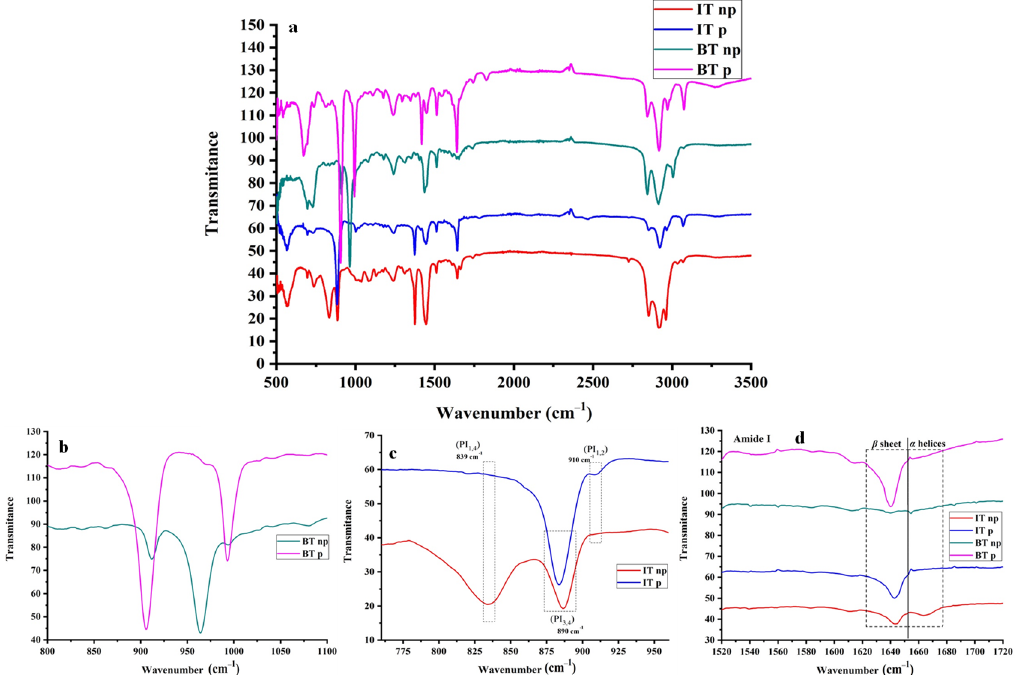
Figure 2. IR spectra correspond to all synthesized hybrid materials. The spectra in ( a ) correspond to wavelengths from 0 to 3500 cm –1 , ( b – d ) to magnified areas from 800 to 1100 cm − 1 and 760 to 950 cm − 1 and 1520 to 1720 cm − 1 respectively.